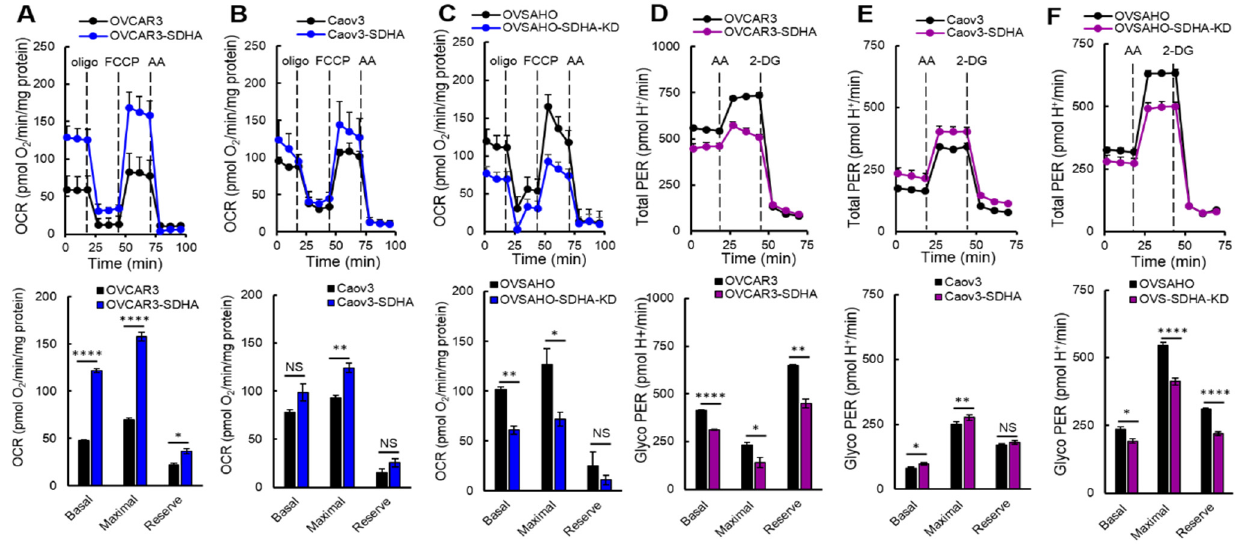
Figure 5. SDHA increases mitochondrial respiration in ovarian cancer cell lines. ( A – C ) OCR was measured in ovarian cancer cell lines overexpressing SDHA or SDHA KD cells vs. controls by the Seahorse XF Cell Mito Stress Test. Cells were challenged by oligomycin “oligo”, FCCP, and antimycin A “AA”. Basal OCR represents the mitochondrial respiration at resting state, the maximum respiration indicates the cellular response to an increased ATP demand, and respiratory reserve indicates the cell capacity to utilize mitochondria during periods of high-energy expenditure. ( D – F ) Glycolytic Rate Assay was performed to calculate Proton Efflux Rate (PER) derived from glycolysis (glycoPER) in ovarian cancer cell lines overexpressing SDHA or SDHA KD cells vs. controls. Cells were challenged with AA to inhibit mitochondrial oxygen consumption followed by addition of 2-DG. The obtained PER values allowed to calculate basal glycolysis and maximal glycolysis, and glycolytic reserve. Data are represented as mean ± SEM, illustrating differences in OCR between cell lines (unpaired t -test, **** = p < 0.0001, ** = p < 0.01 * = p < 0.05, NS = not significant).